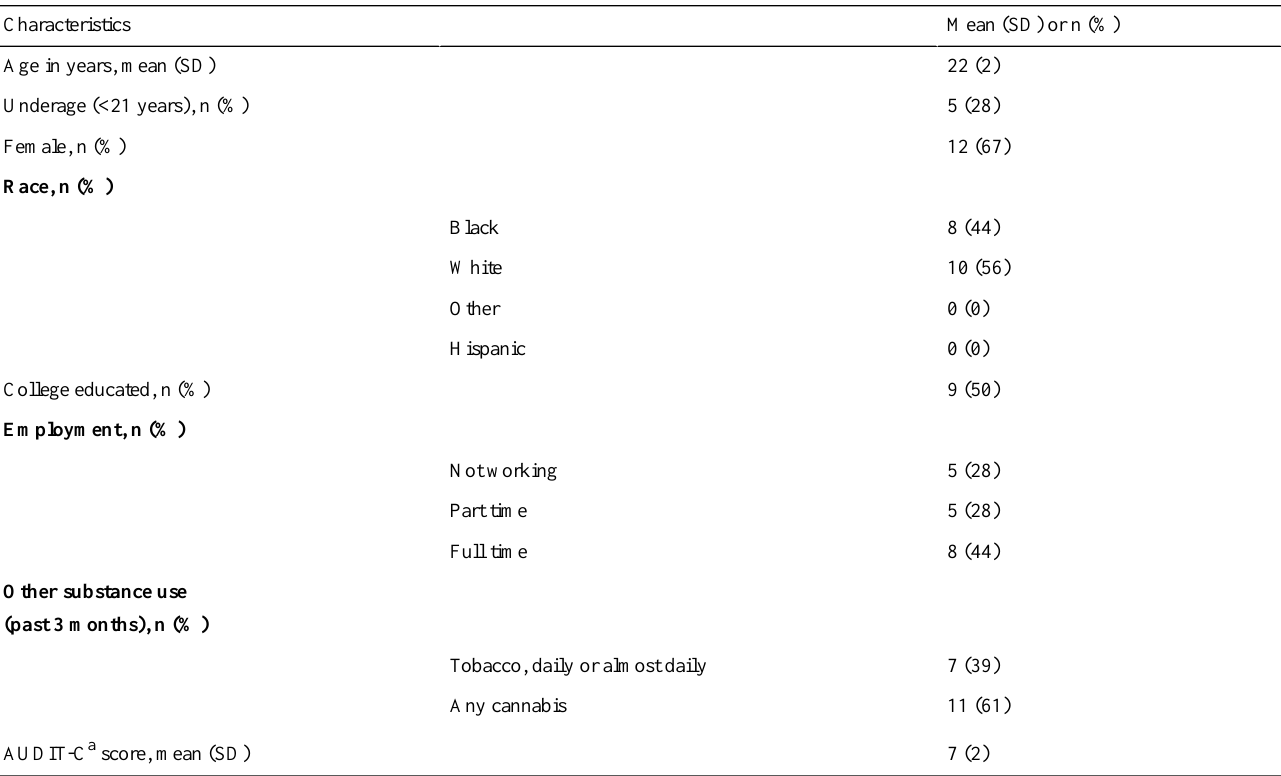
Table 1. Baseline characteristics of focus group participants